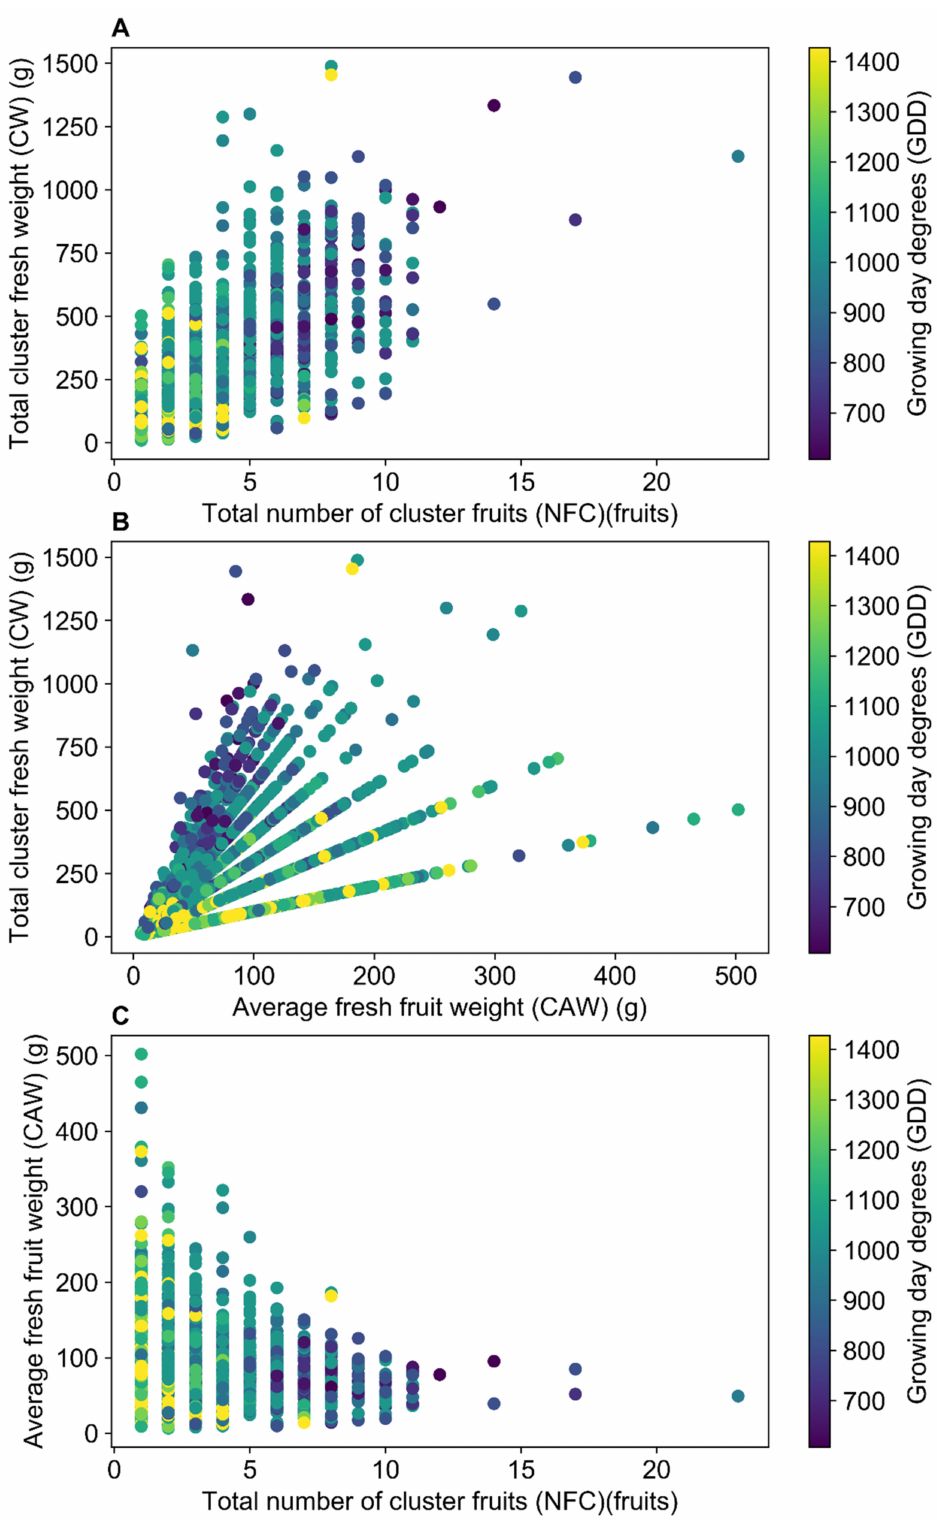
Figure 4. Cluster components to the first harvested fruit of each cluster of each plant individually. ( A – C ) Within cluster relationships between number of fruits, fruits fresh weight and clusters total weight, colored by growing degree days